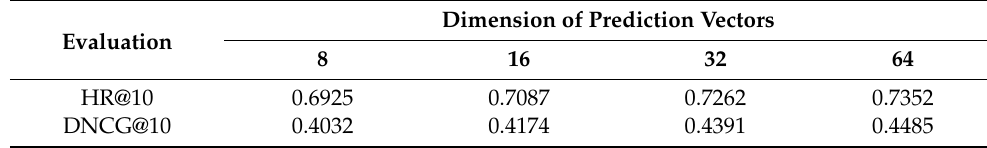
Table 3. The impact of different dimensions of prediction vectors on ml-1m. Evaluation